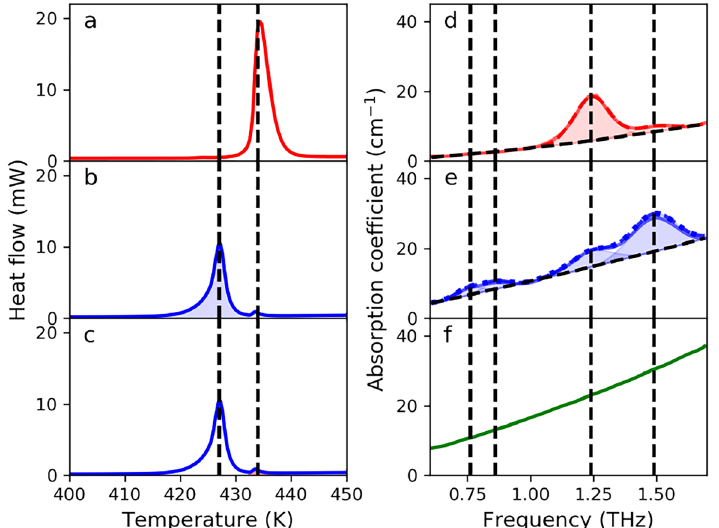
Figure 1. ( a ) DSC curve for γ -IM which shows a single peak at 434.3 K. ( b , c ) DSC curve for the recrystallized-IM which shows a strong peak at 427.0 K and a weak peak at 434.3 K. The area shaded in light blue in panel ( b ) corresponds to the α -IM, while the area shaded in light red in panel ( c ) corresponds to the γ -IM present in the recrystallized sample. ( d ) THz absorption spectrum of γ -IM (red solid line) with fitted featureless background absorption (black dashed line), and two fitted characteristic absorption peaks (i.e., G γ ,1 and G γ ,2 , shaded area). Dashed red line corresponds to the fitted spectrum. ( e ) THz absorption spectrum of the recrystallized-IM sample with fitted featureless background absorption (black dashed line), and four fitted characteristic absorption peaks (i.e., G α ,1 - G α ,4 , shaded area). Additionally, the estimated α -IM absorption is shown as a dotted blue line and the dashed blue line corresponds to the fitted spectrum. ( f ) THz absorption spectrum of the A-IM.